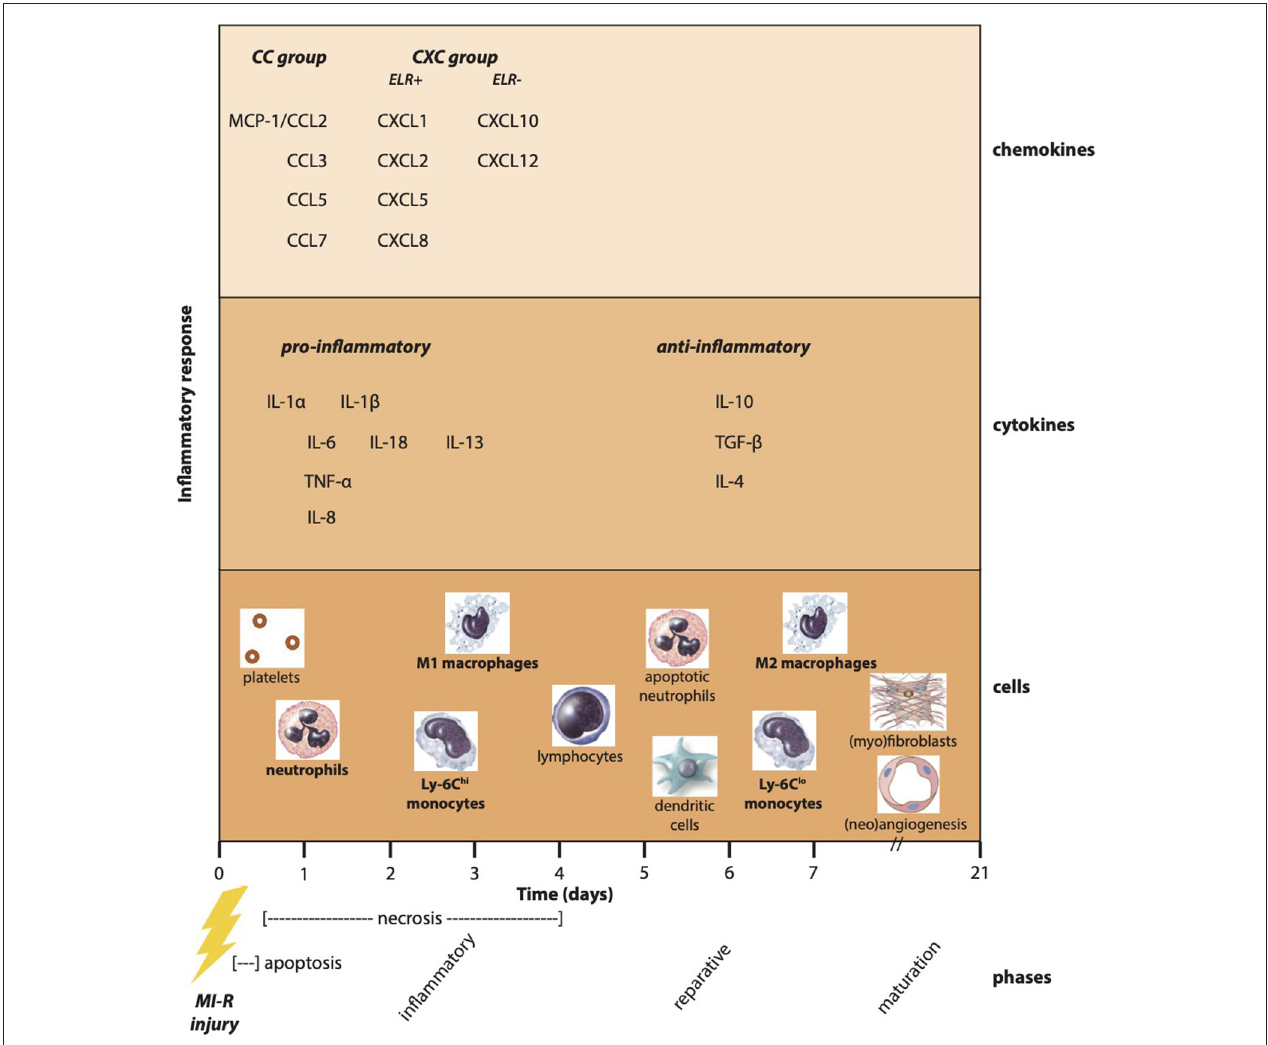
FIGURE 2 | Post-ischemic inflammatory response. Myocardial infarction especially followed by reperfusion results in a complex post-ischemic inflammatory response encompassing a multifactorial and dynamic process. Apoptosis and necrosis activate the innate immune system resulting in the upregulation of pro-inflammatory chemokines and cytokines. As a result, inflammatory cells are attracted to the ischemic myocardium known as the inflammatory phase. In addition, the production of anti-inflammatory cytokines causes a transition toward the reparative phase accompanied by reparative monocyte and macrophage subtypes. Finally, (myo)fibroblasts and angiogenic cells ensure the formation and maturation of myocardial scar